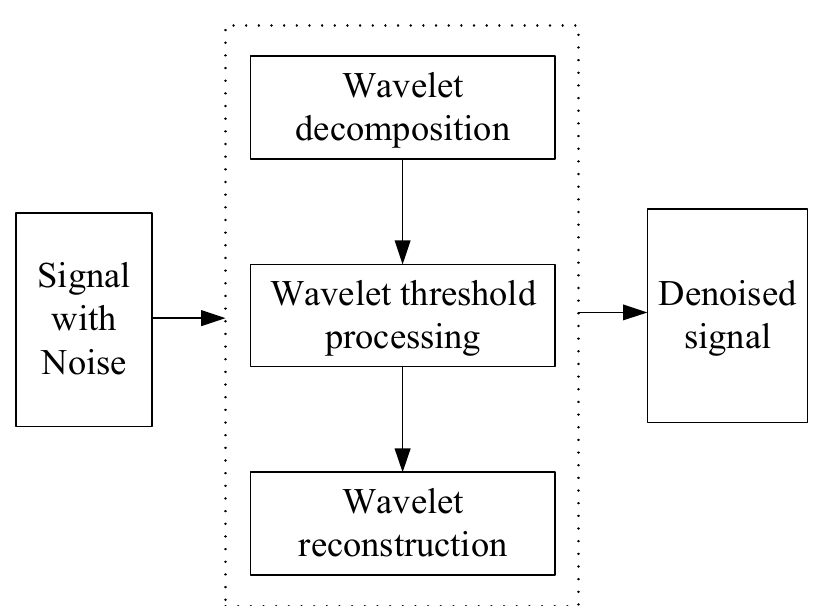
Figure 12. Wavelet transformation signal denoising process.